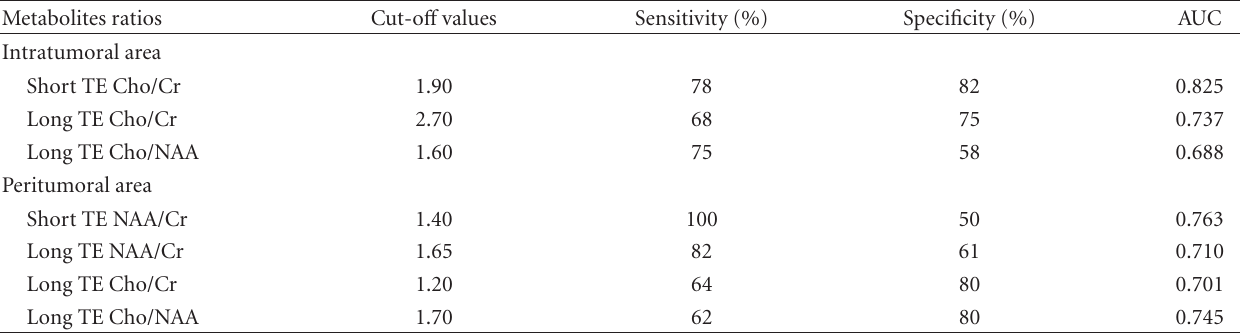
Table 3: Measures of the optimal cut-o ff values with their corresponding sensitivities and specificities of the metabolic ratios which provide a statistical di ff erentiation between high and low grade